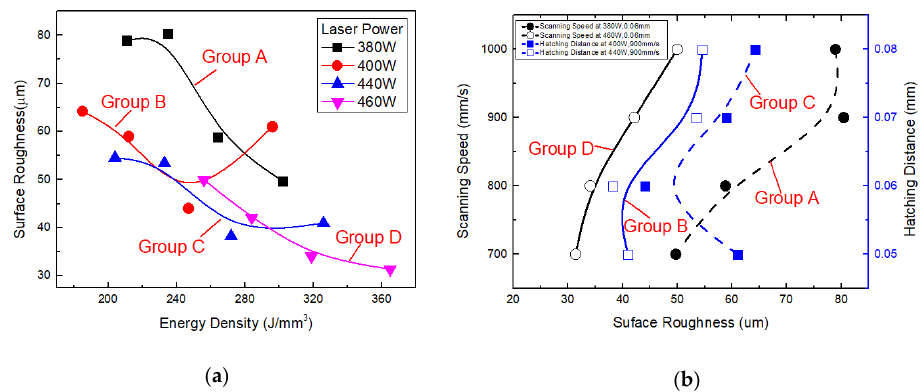
Figure 13. Surface roughness of the alloy formed by SLM under different process parameters: ( a ) laser power and surface roughness versus energy density of the alloy and ( b ) scanning speed and hatching distance versus surface roughness of the alloy.